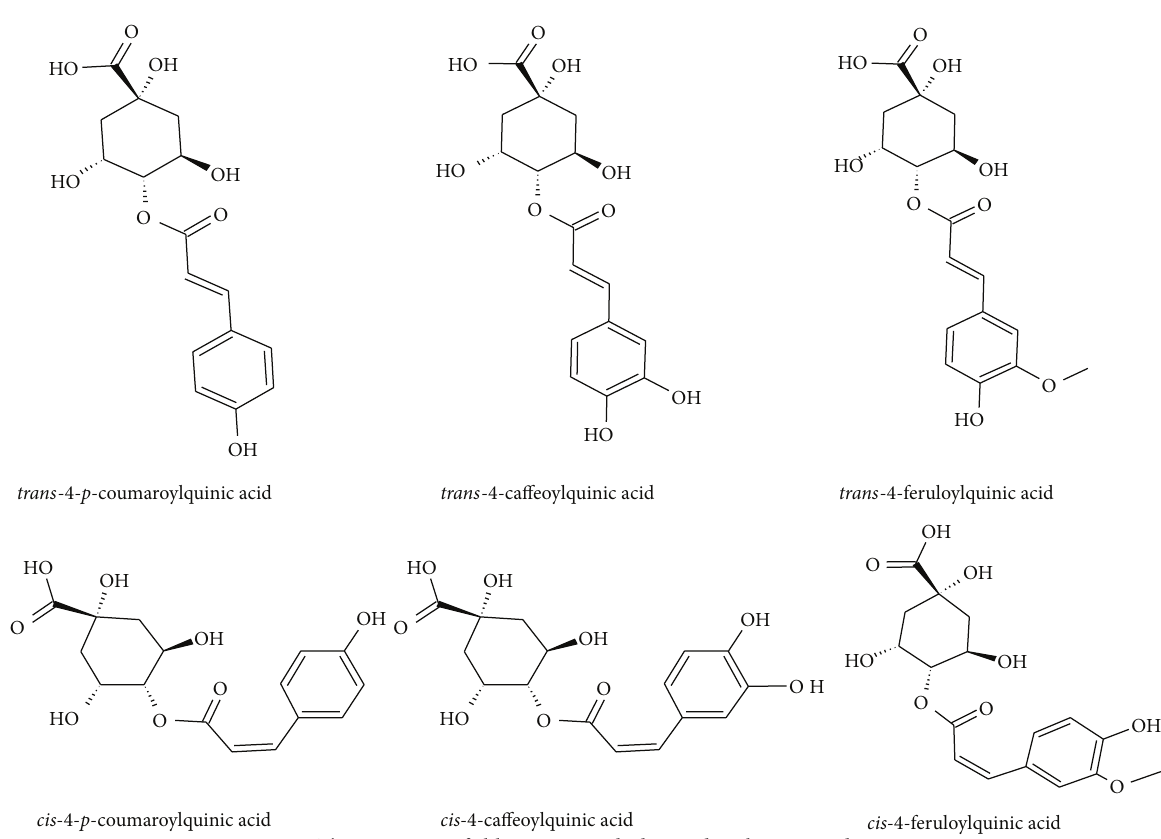
Figure 2: The structures of chlorogenic acids detected in the Momordica